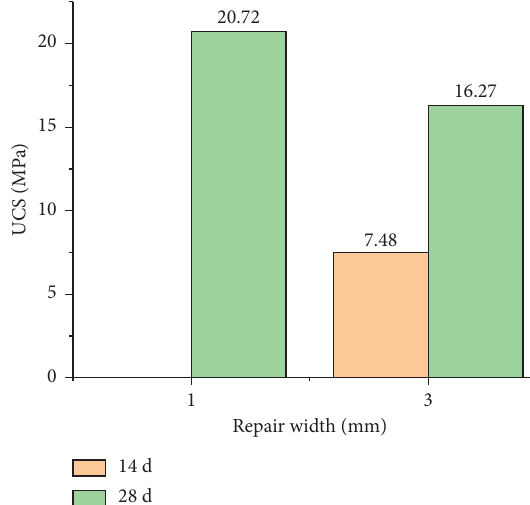
Figure 31: UCS of UPC-repaired samples with crack widths of 1mm at day 14 and 1mm and 3mm at day 28.